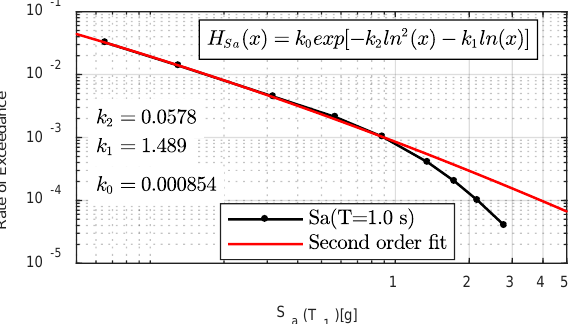
estimating period as illustrated in Equation (1); the hazard second order fit coefficients have been found to be k 0 = 8.54 × 10 − 4 , k 1 = 148.95 × 10 − 2 , and k 2 = 5.78 × 10 − 2 , as illustrated in Figure A2. These parameters are implemented in Equations (2)–(5) to compute the annual probability of exceeding the limit state (as presented in Table 8) associated with the given mechanism. The required hand calculation is presented below for illustration.